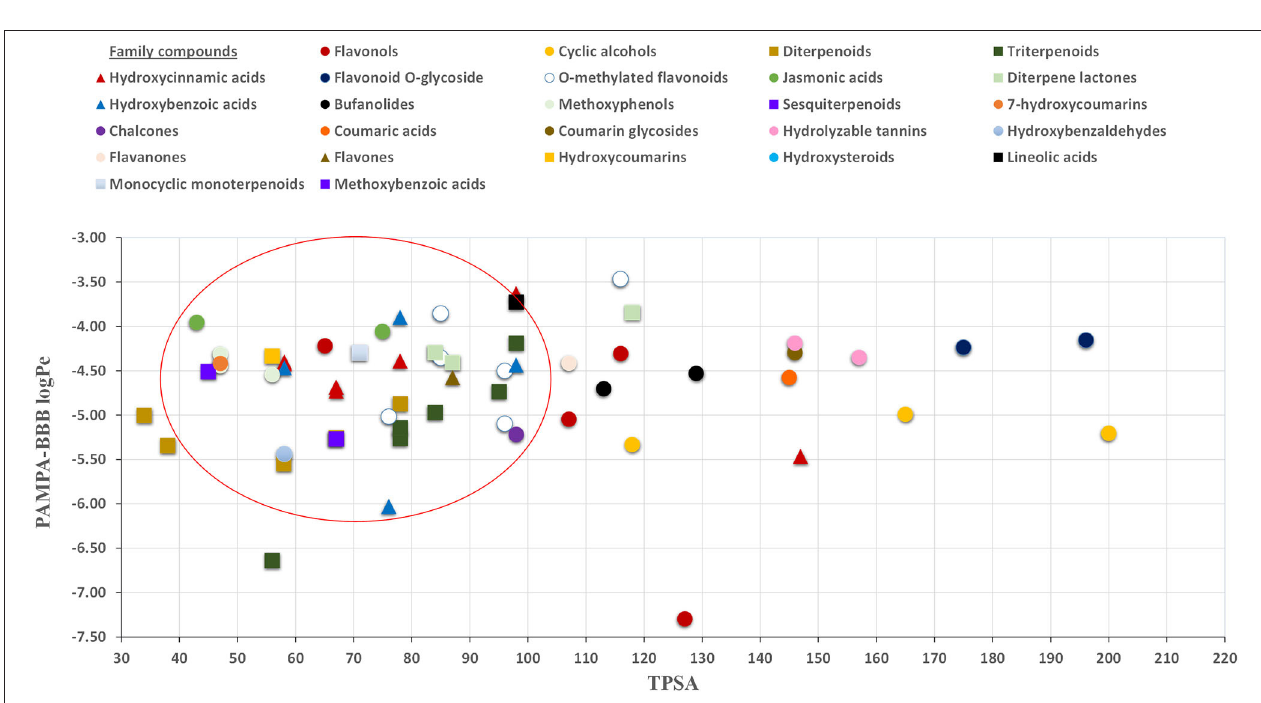
FIGURE 4 | Relationship between PAMPA-BBB logPe and TPSA (topological polar surface area).